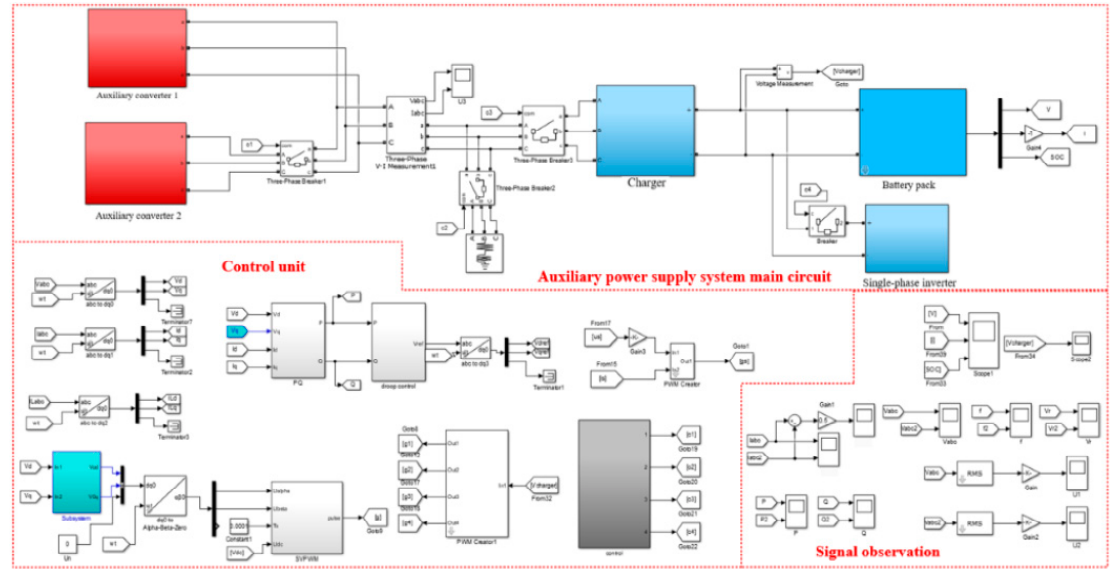
Figure 12. Diagram of the overall connection of the auxiliary power supply system.